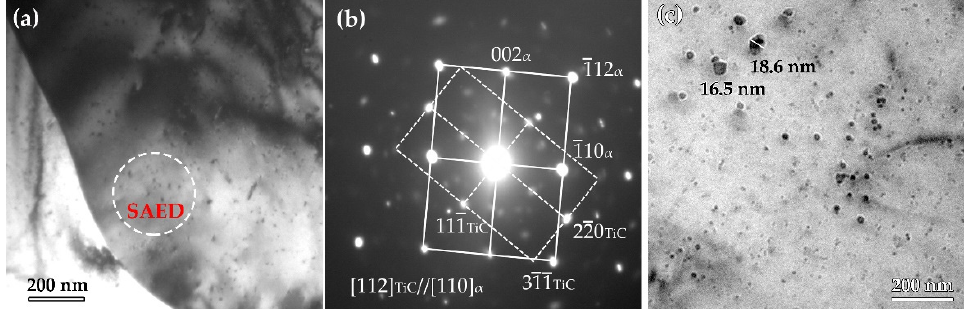
Figure 9. TEM images of precipitates formed in steel A. ( a ) precipitates in surface region; ( b ) SAED pattern, ( c ) precipitates in mid-thickness region.